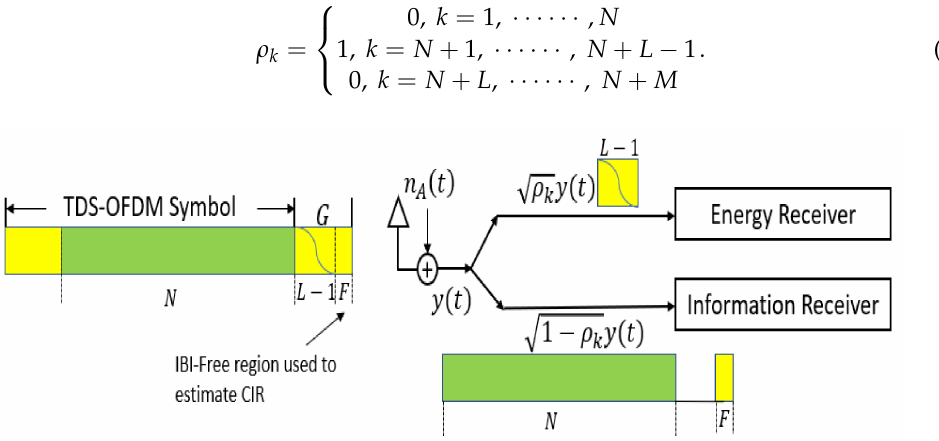
Figure 5. Architecture for the proposed energy harvesting receiver in IoUTs nodes based on TDS- OFDM communication